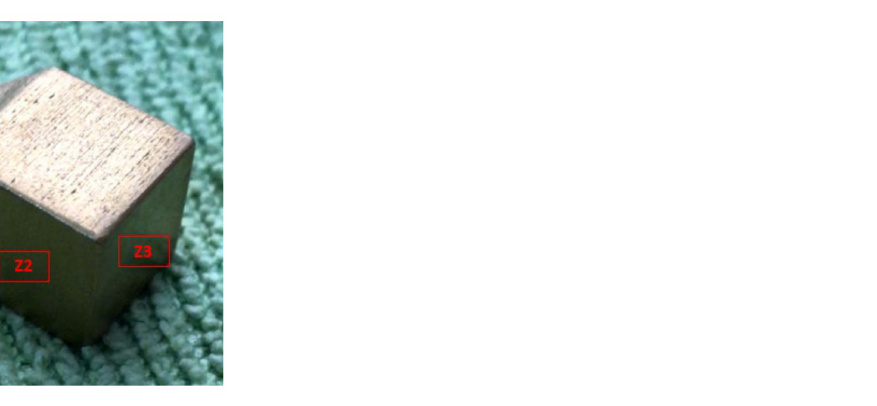
Figure 5. Zones of study on the representative sample of set 2. Z1—top (4 faces), Z2—walls (4 faces), Z3—bottom (1 face).